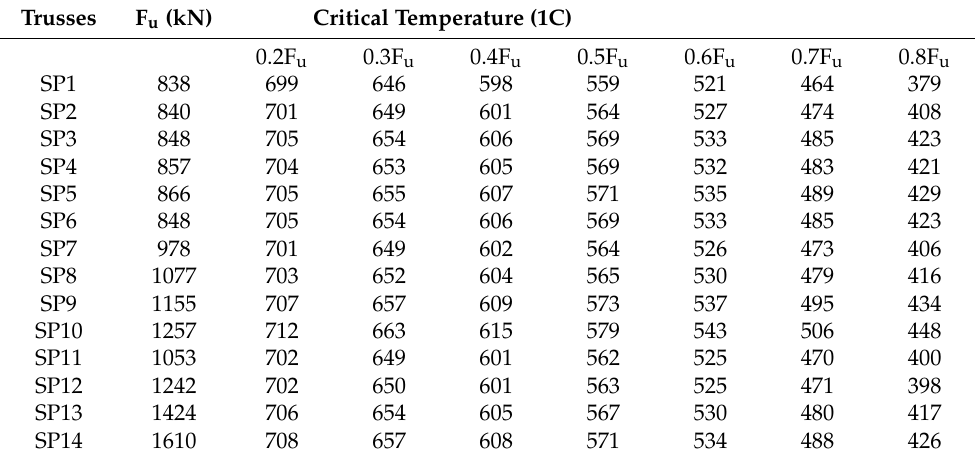
Table 1. Link between load ratios, critical temperature, and fire susceptibility [45].